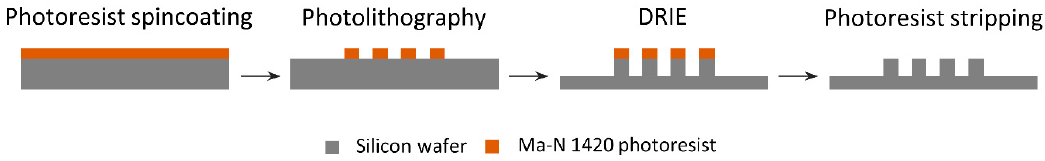
Figure 1. Schematic representation of the proposed micropillar mold fabrication procedure, including photoresist spin-coating, photolithography, DRIE and stripping of the photoresist.